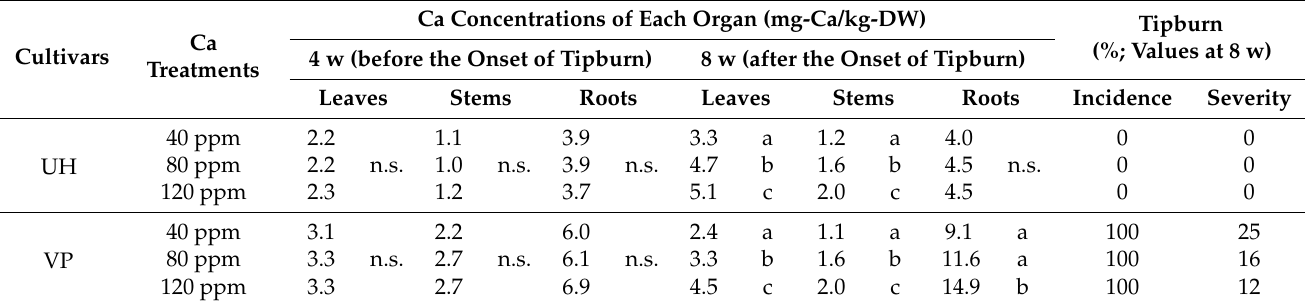
Table 1. Ca concentrations in each organ, tipburn incidence and severity of tipburn-absent cultivar (UH) and tipburn- damaged cultivar (VP) at weeks 4 and 8 cited from a previous study [13].